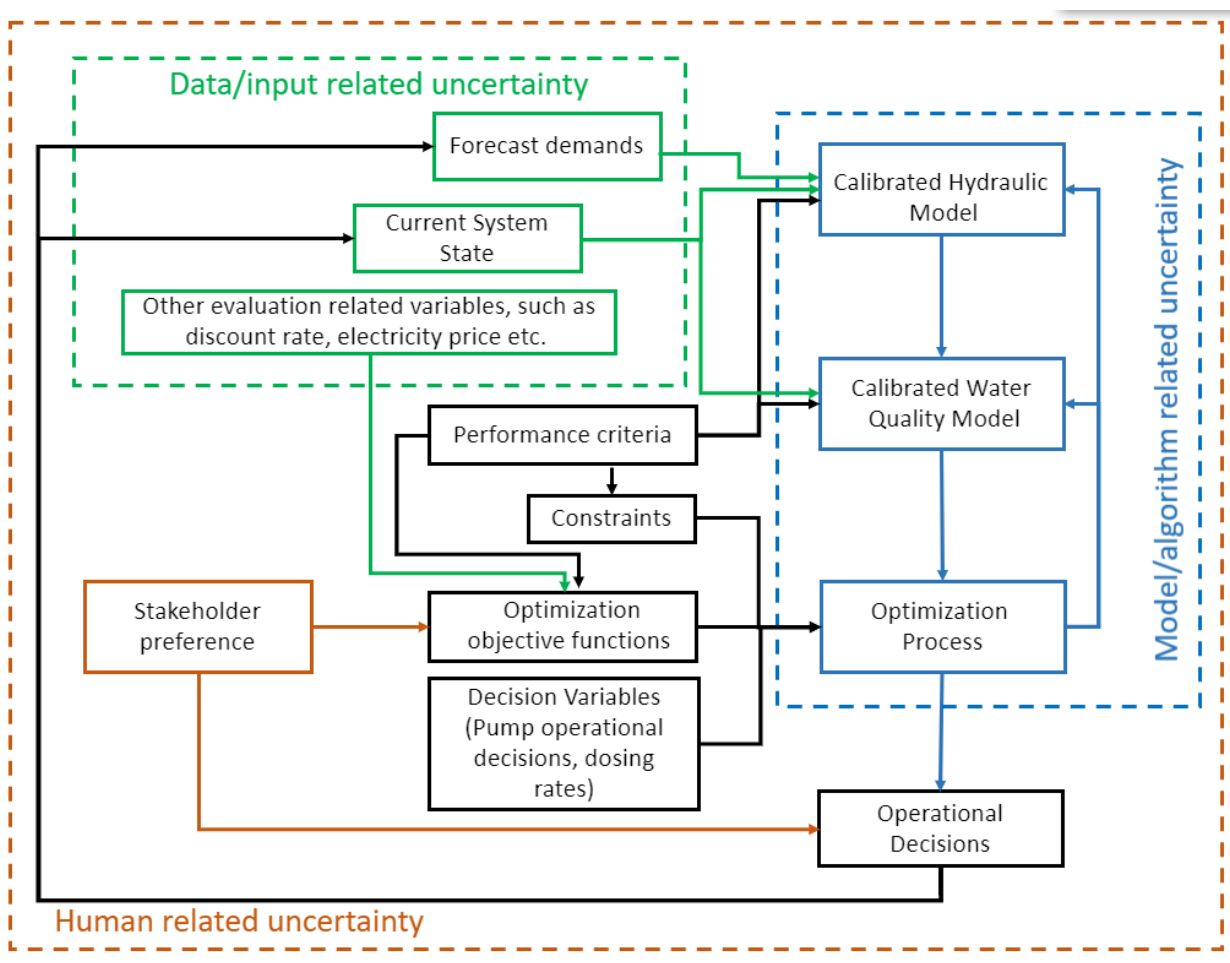
Figure 2. Steps involved in Optimizing the Operations of WDS and the Various Sources of Uncertainty. The various sources of uncertainty are discussed in more detail